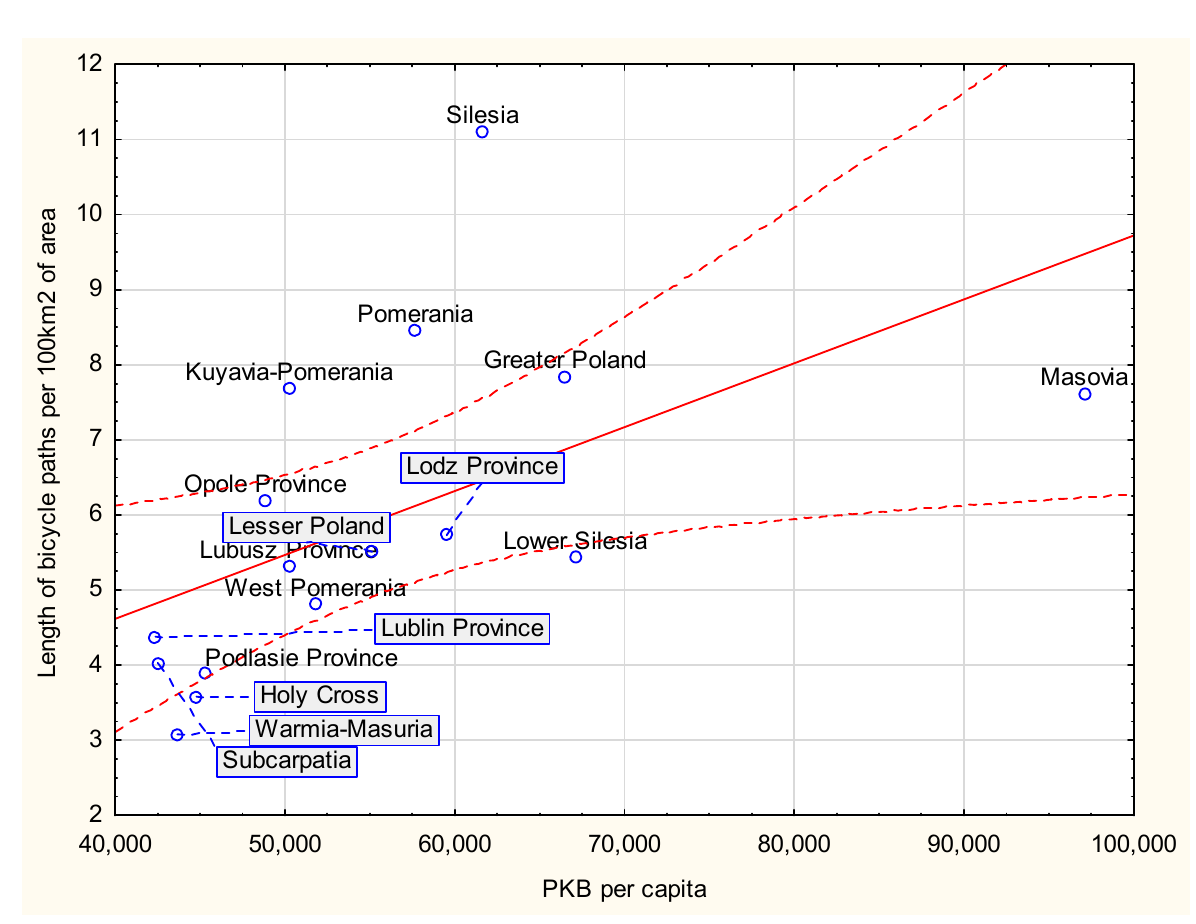
Figure 7. Relationship between the length of bicycle paths per 100 km 2 of area in a given wo-village and GDP per capita. Source: Author own analysis.